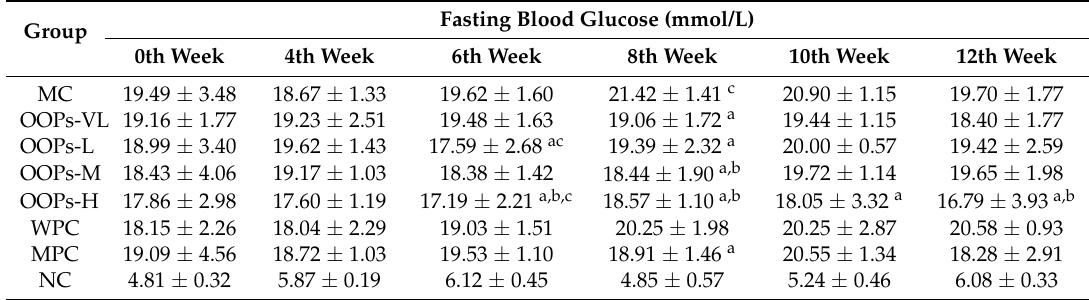
Table 2. Effect of OOPs intervention on fasting blood glucose in rats.